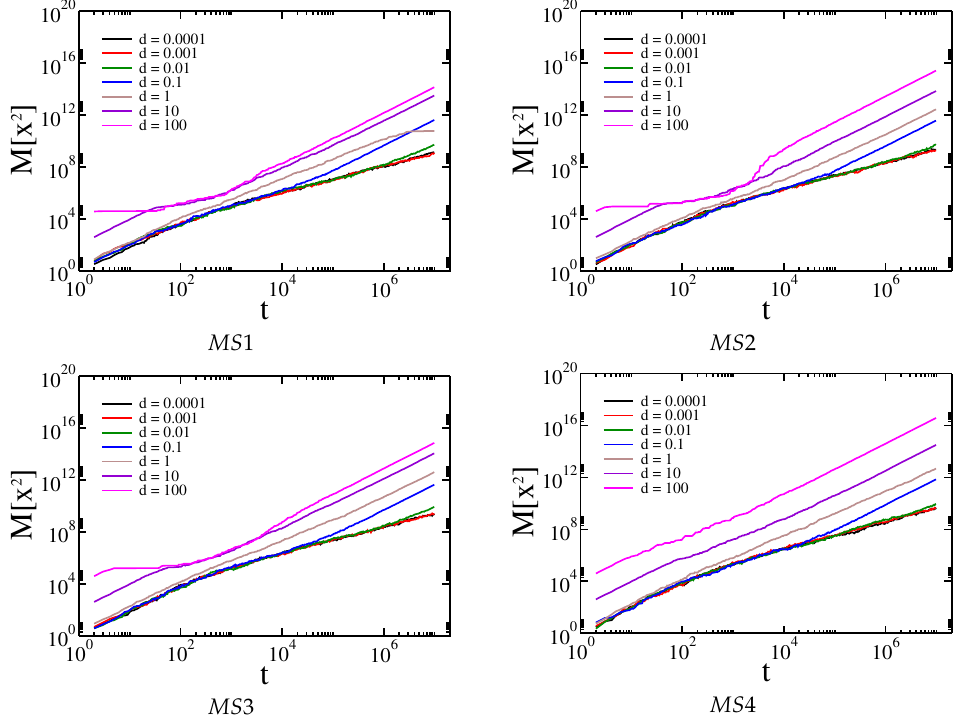
Figure 5. Dependence of the median of the square displacement x 2 on time driven by Cauchy flights moving in the structures MS1, MS2, MS3, and MS4, respectively.